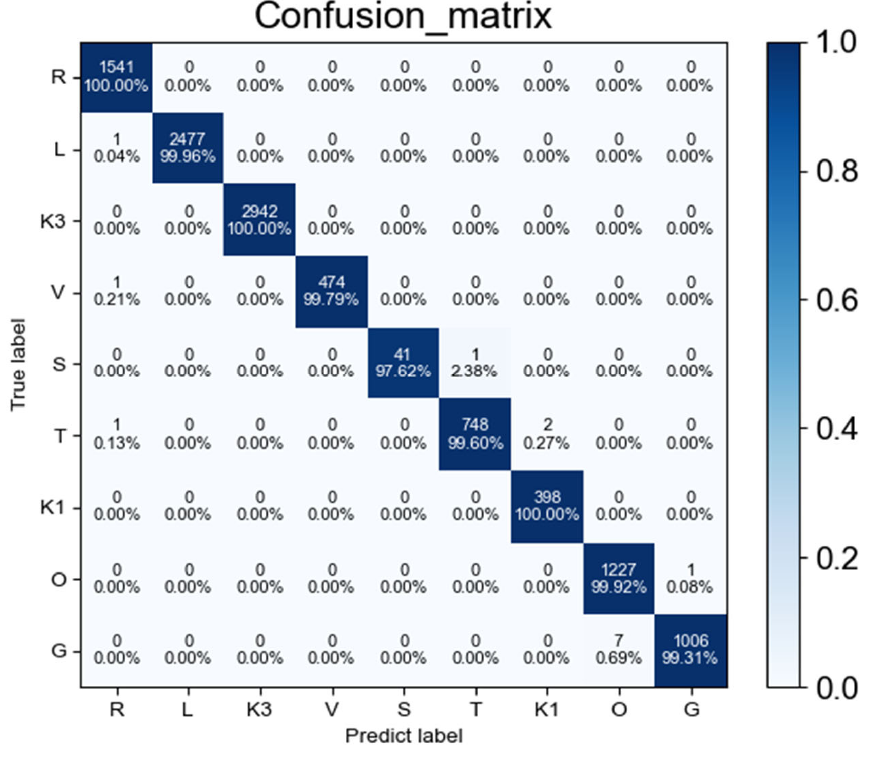
Figure 5. Confusion matrix of fused features based on XGBoost classi fi er.